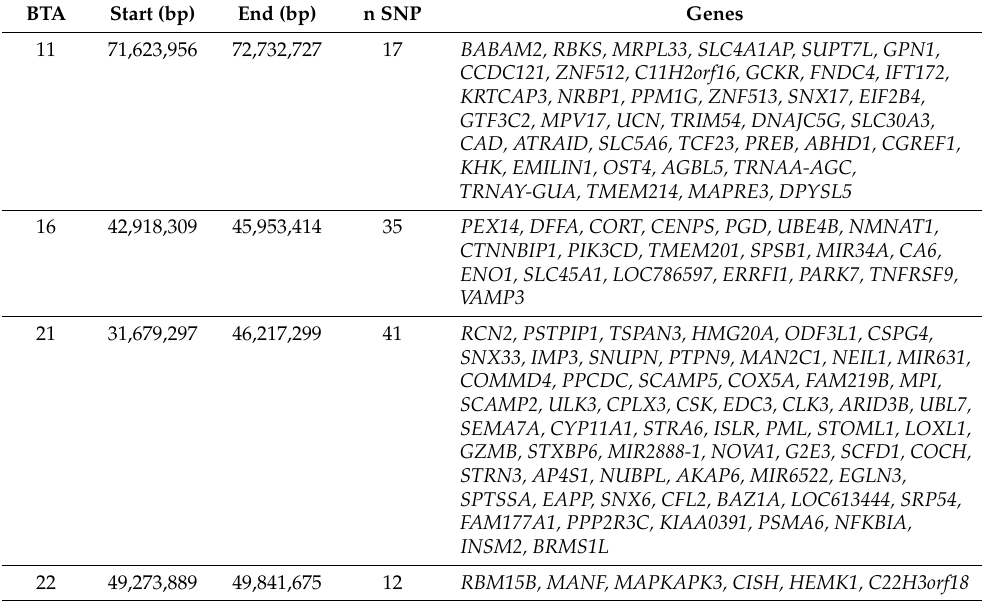
Figure 4. Manhattan plot of the SNP frequency within runs of homozygosity by autosome in the Tropical Milking Criollo cattle population. Table 5. Description of the runs of homozygosity (ROH islands) found in the autosomal genome of the Tropical Milking Criollo cattle population.